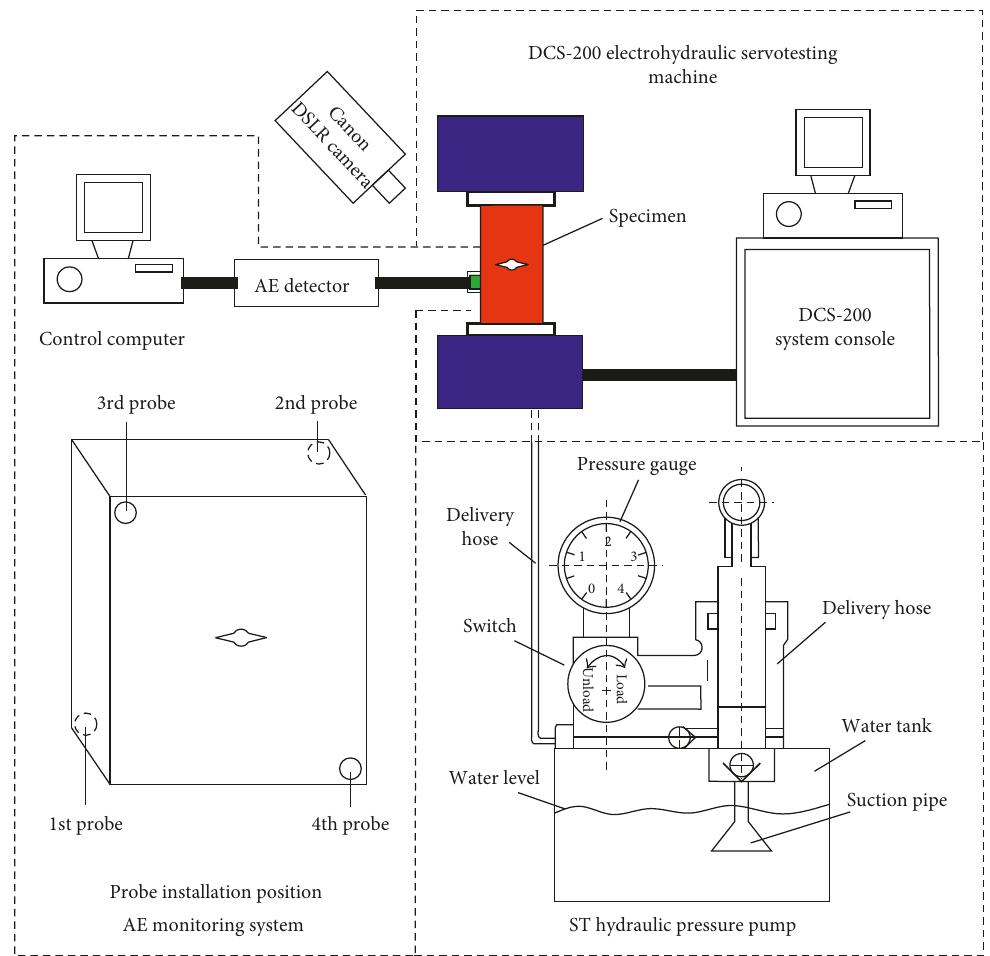
Figure 2: Schematic representation of experimental setup.